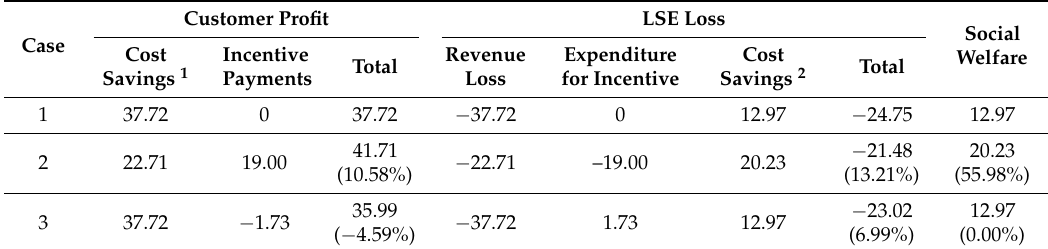
Table 4. Total profit and loss on Day 3 (unit: $).